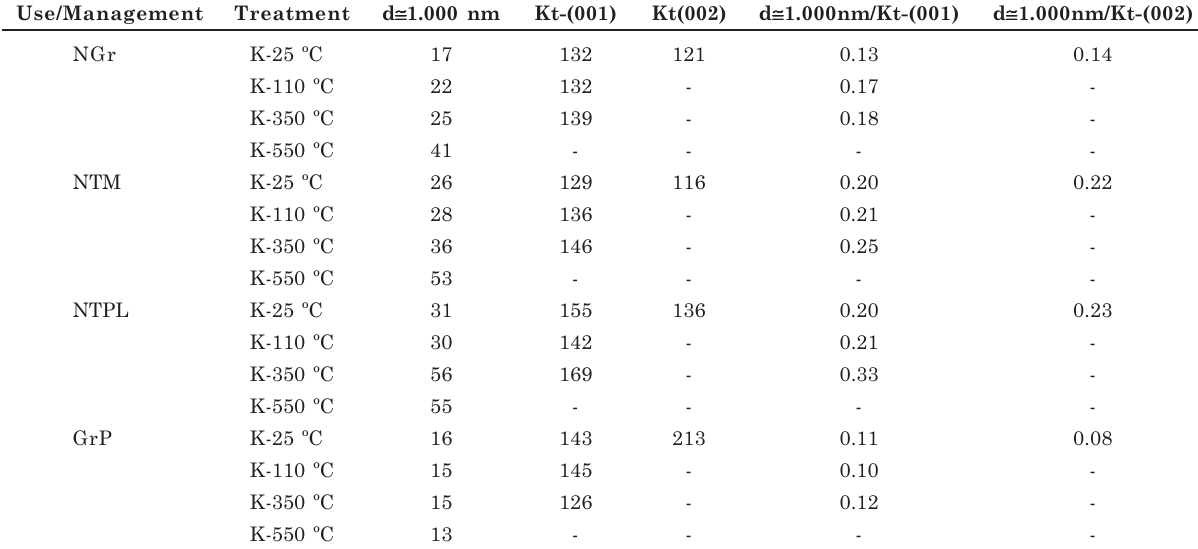
Figure 2. X-ray diffraction patterns of oriented iron-free clay fraction of a Rhodic Paleudult under natural grassland (NGr) and grazed native pasture with cattle droppings (GrP) after expansion and contraction treatments of 2:1 clay minerals. Kt: kaolinite; Qz: quartz; An: anatase. (K-C: K-saturated samples heated at different temperatures, Mg-25 o C: Mg-saturated samples at 25 o C, Mg+Gl: Mg-saturated and glycerol- solvated samples). ≅ Table 6. Reflection area (cps × deg) of the spacings d 1,000 nm and of the kaolinite hkl planes 001 and 002 and their ratios in a Rhodic Paleudult under four land use and management